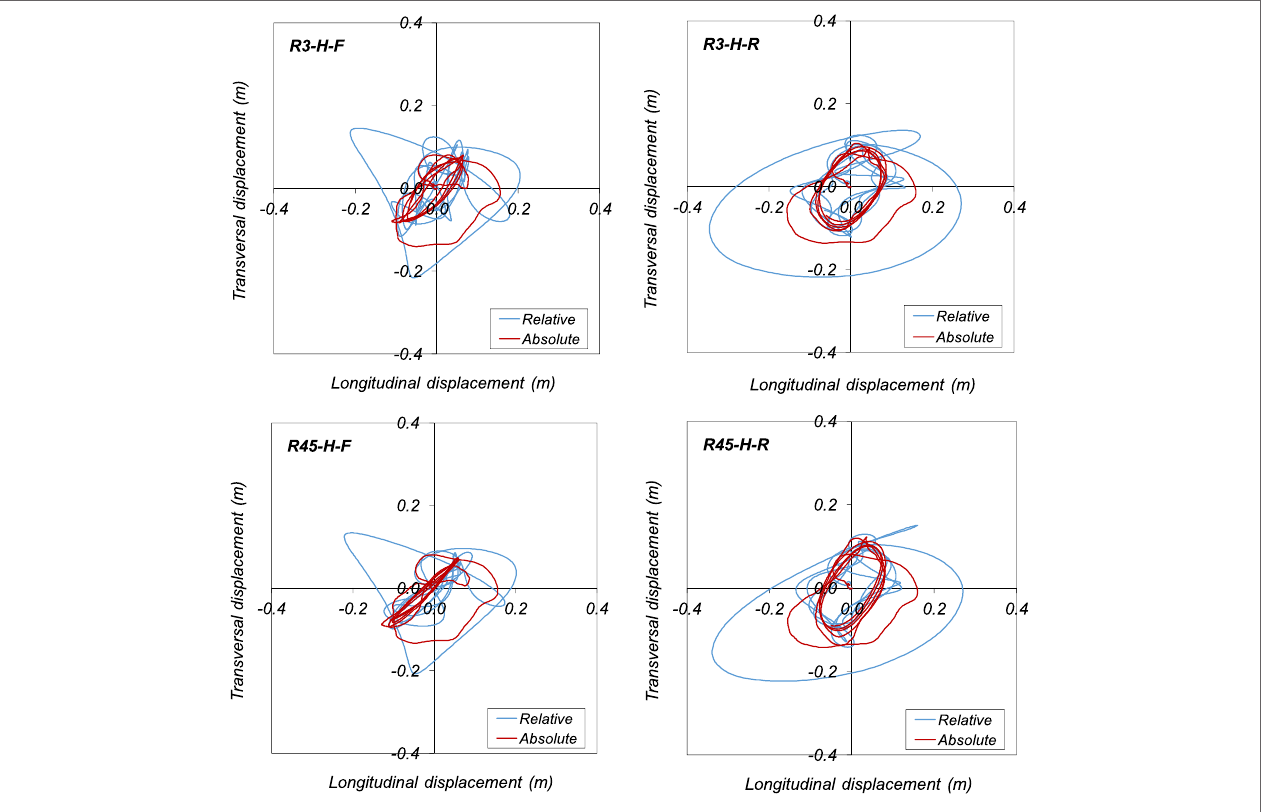
FigUre 15 | Displacement of the hoist mass in the R3-H-F, R3-H-R, R45-H-F, and R45-H-R